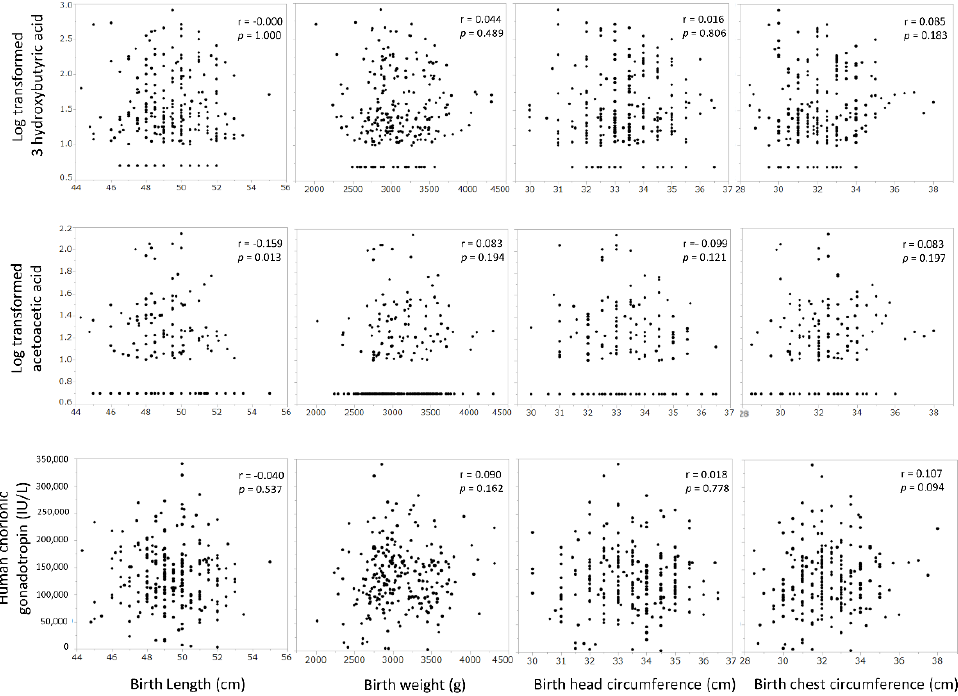
Figure 4. Relationship between serum levels of ketone bodies or human chorionic gonadotropin in the first trimester with the neonatal body shape.